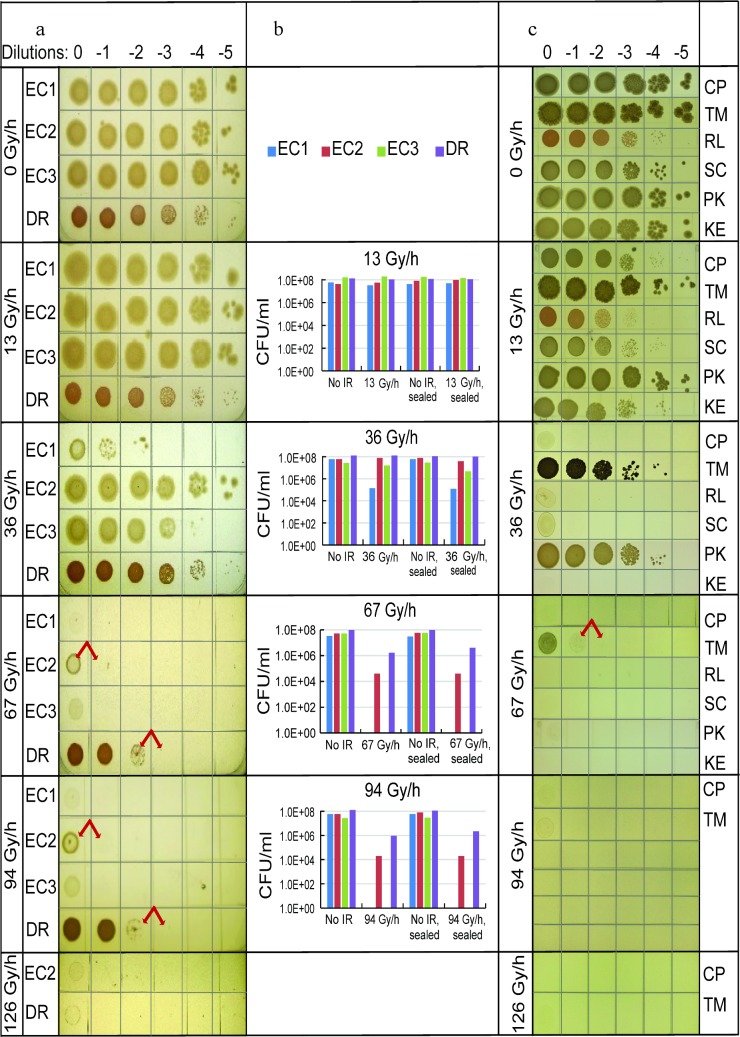
Aerobic growth of microorganisms under CIR.a: Bacteria. b: Clonogenic survival of bacteria under CIR. For the corresponding CIR study under microaerobic conditions, see S1 Fig. In this and the following figure, dilutions shown in panels a and c are on a log10 scale and represent order of magnitude changes in initial cell concentration. The bars shown in panel b are based on CFU counts normalized to 1 ml: the actual numbers of viable cells are 200 times smaller because only 5 μl of each species were used in these experiments. At 94 Gy/h, individual colonies could not always be reliably identified, and therefore the bars at this dose rate represent estimates. Abbreviations: No IR = no irradiation; sealed = microaerobic. Red arrows indicate cases where 10-fold reduction in cell concentration completely extinguished growth at a given dose rate. c: Fungi.